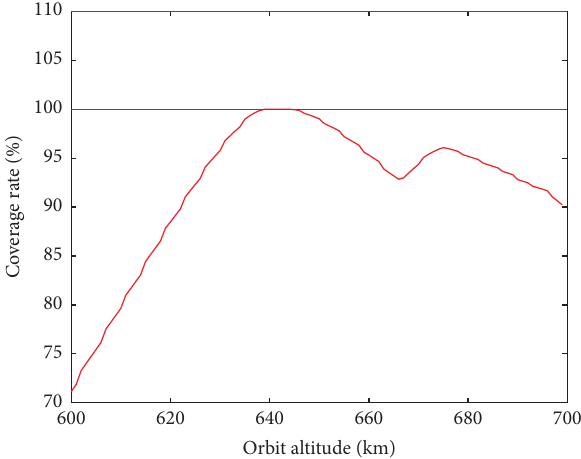
Figure11:Therelationshipbetweenthecoveragepercentageandthe altitude for HJ-1A.